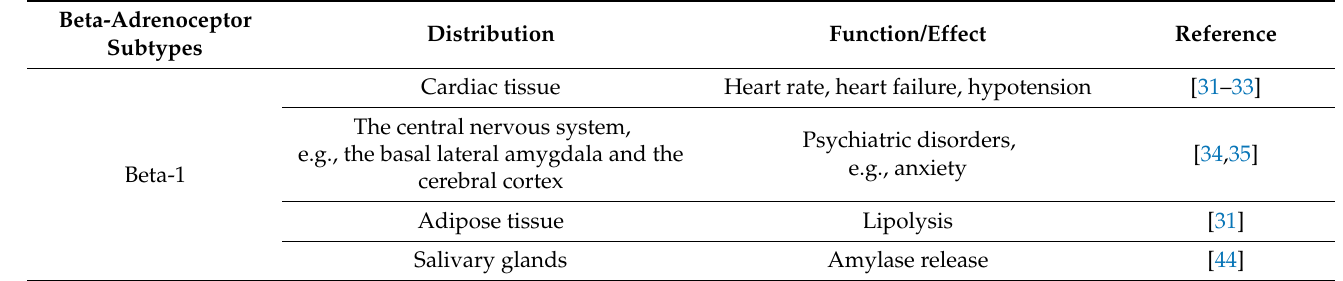
Table 1. A summary of the distribution and functions of the three beta-adrenoceptor subtypes.